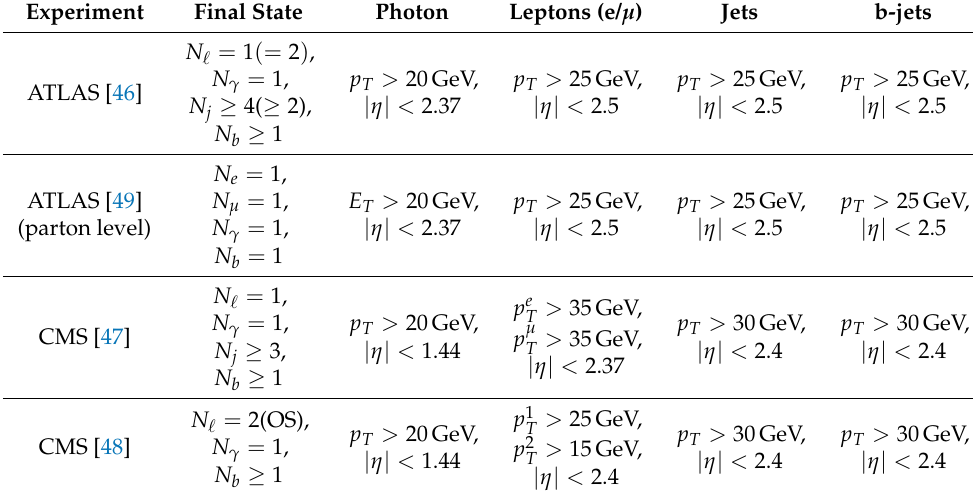
Table 1. Table outlining the fiducial selections made in each analysis. All selections are made on particle-level objects except for the ATLAS dilepton measurement. Additional requirements ensure leptons (in all cases, only electrons and muons are considered) are isolated and that the lepton energy incorporates that of radiated photons. Additional photon requirements also ensure isolation and that it does not originate from hadronic decay. Additional vetoes are applied to events in which leptons and photons are produced in close proximity. In particle-level selections, b-jets are defined using ghost-matching [52]. Leptons in the parton-level definition are required to come from the W-boson decay. Superscripts 1 and 2 refer to objects ordered by transverse momentum from highest to